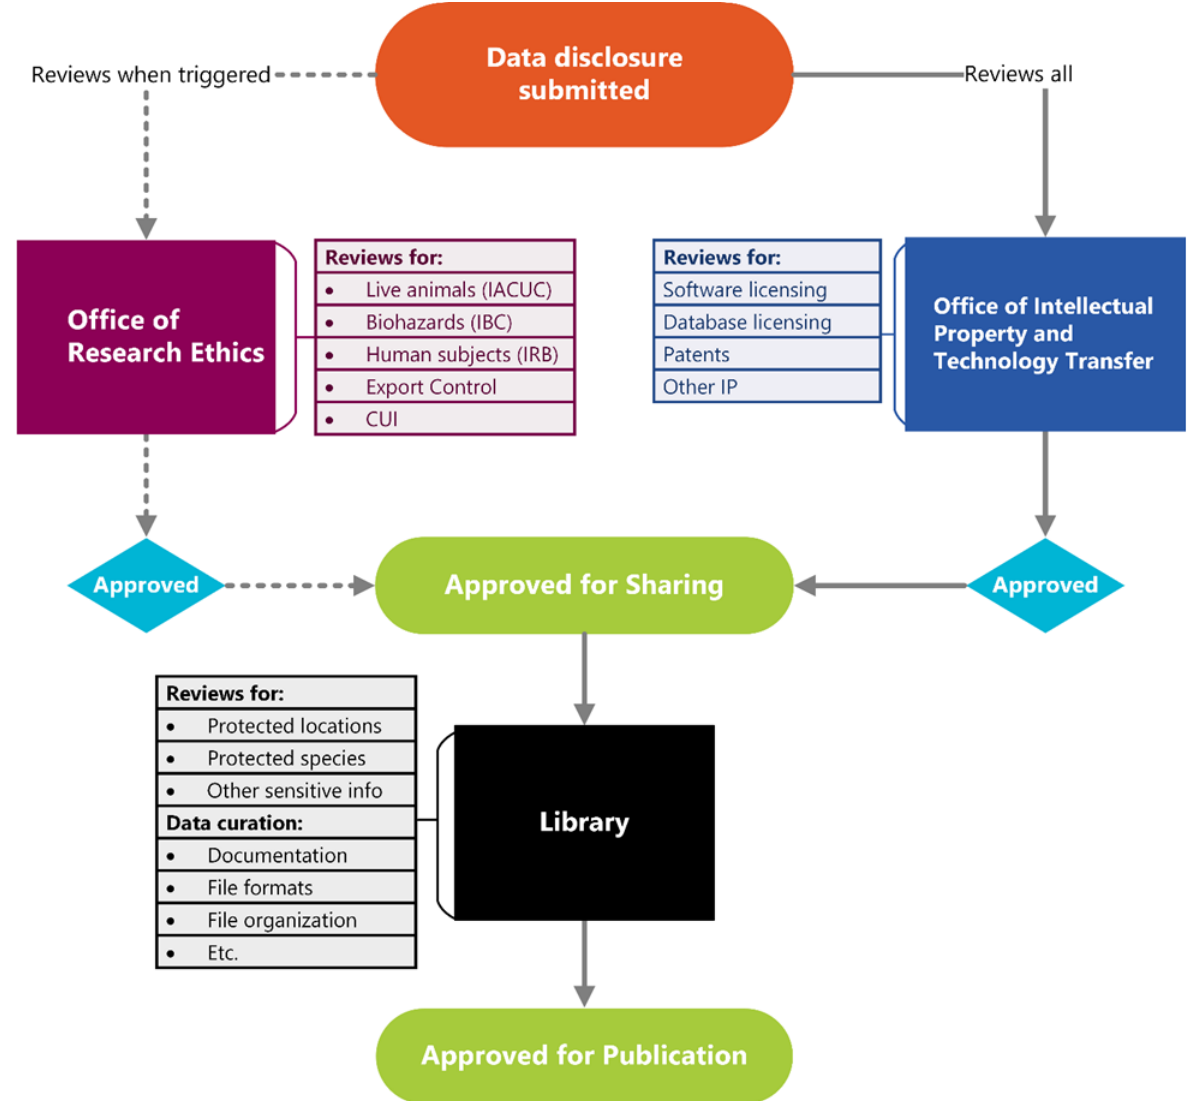
Figure 2 : A diagram overview of the data set disclosure process showing how the Office of Research Ethics and Office of Intellectual Property and Technology Transfer, and the University Library work together to review data set disclosures and data